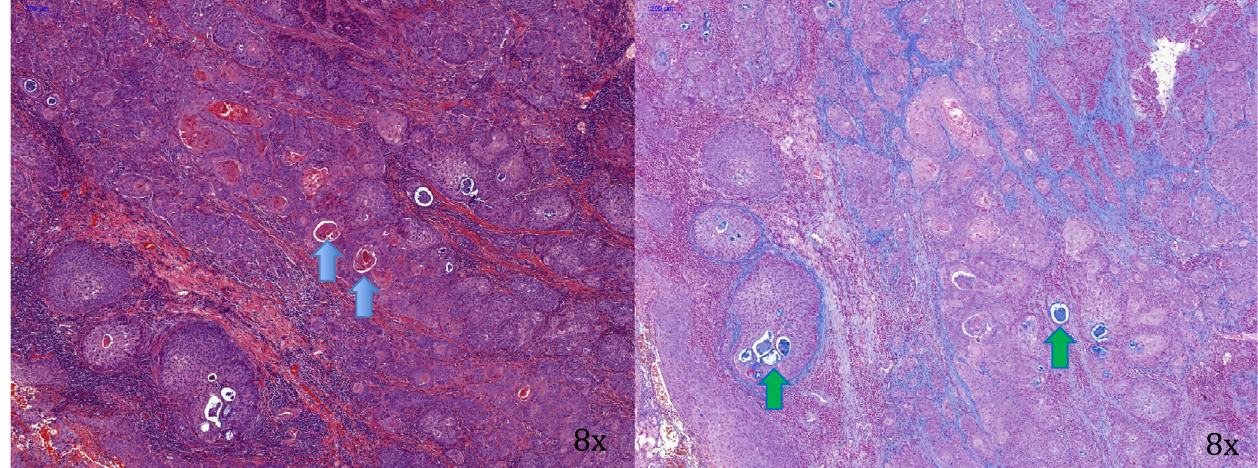
Fig. 2. Biopsy (cid:3) LEFT (hematoxylin & eosin staining (cid:3) HE) keratin pearls (blue arrows) and RIGHT (alcian blue (cid:3) AB) with AB-positive region con fi rming the secretory nature of the glands (green arrows).